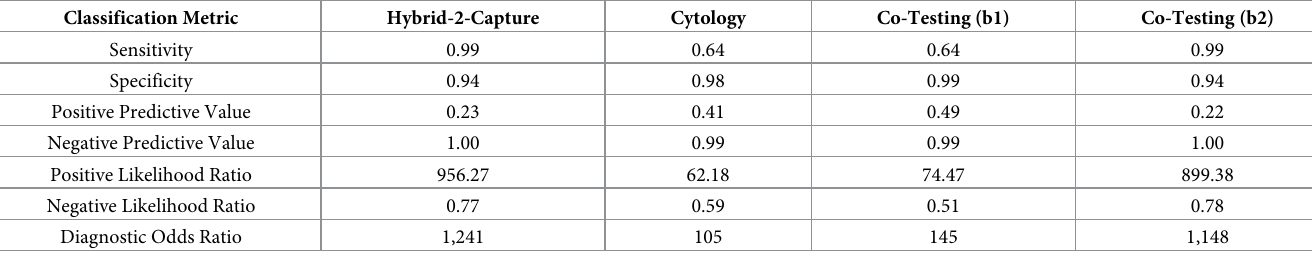
Table 2. Estimated accuracy of cytology, Hybrid-2-Capture, and co-testing (two possible scenarios). Classification